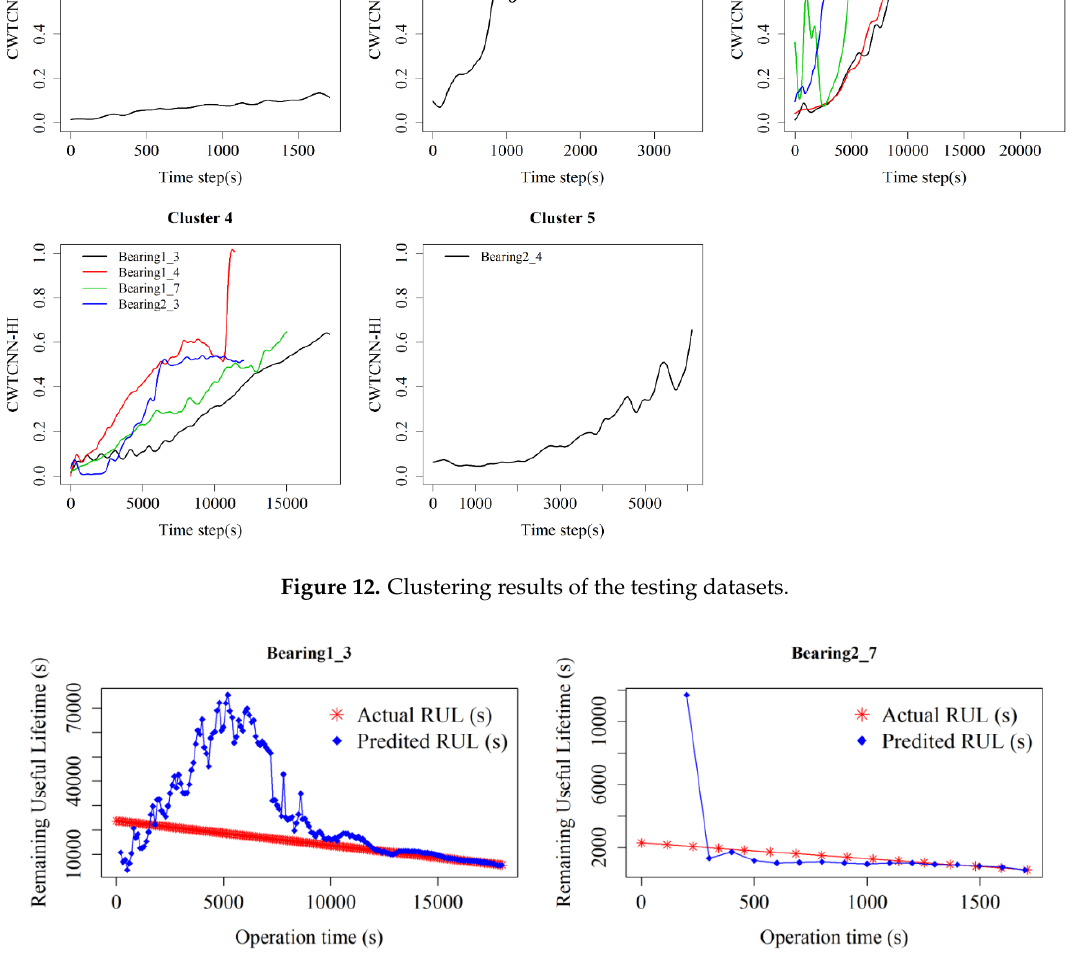
Figure 13. Comparison of the actual RUL and the predicted RUL: ( a ) Bearing 1_3; ( b ) Bearing 2_7.